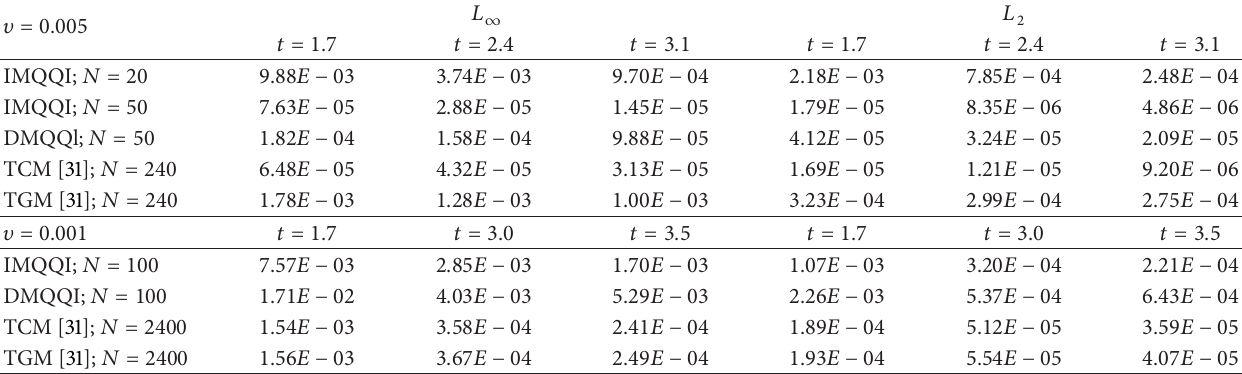
Table 5: The comparison of 𝐿 2 and 𝐿 ∞ errors between the numerical results by using our schemes and the results of [31] with Δ𝑡 = 0.01 , 𝜐 = 0.005 , and 𝜐 = 0.001 of Experiment 2. 𝜐 = 0.005